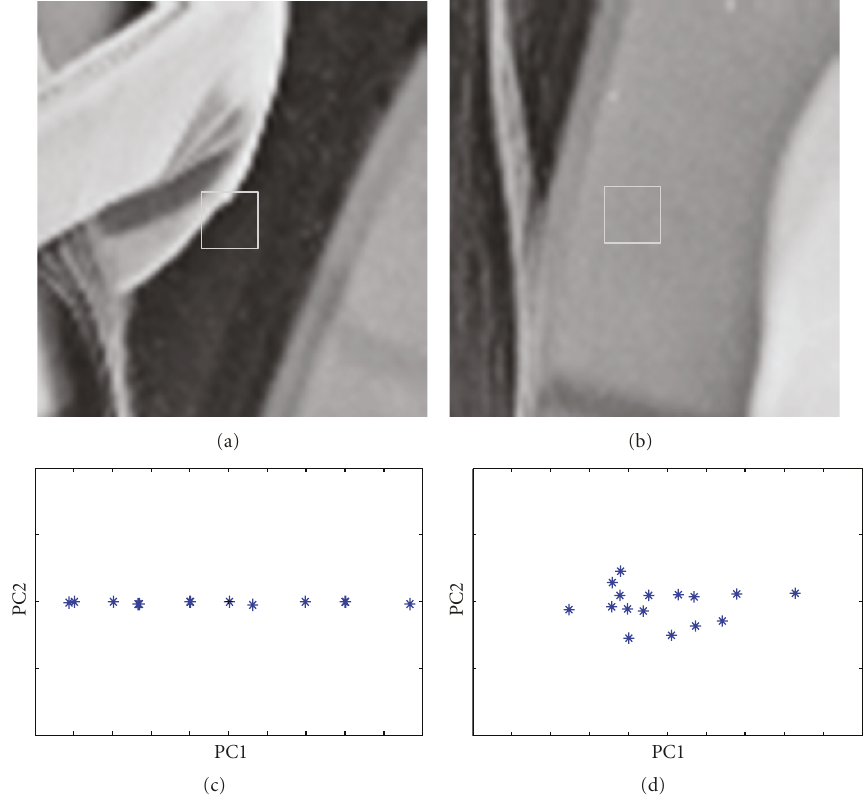
Figure 5: An example to illustrate the correlation between the R value and the strength of the edge. Image blocks with (a) R = 0.9 and (b) R = 0.4 in “Lena”. (c) The distribution of the 16 pixels in block (a) on the two principle components. (d) The distribution of the 16 pixels in block (b) on the two principle